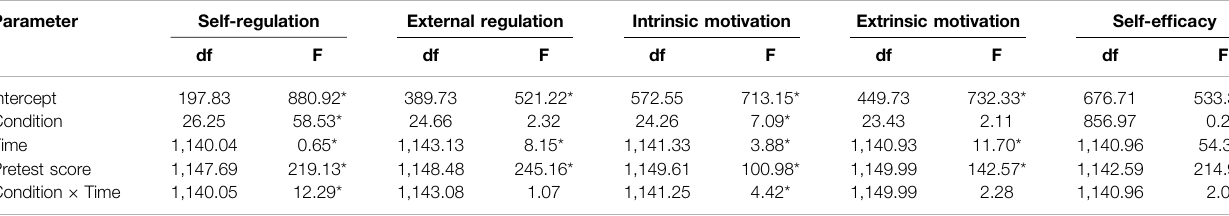
TABLE 6 | Fixed Effects for Predictors of Self-Regulation, External regulation, Intrinsic motivation, Extrinsic motivation, Self-ef fi cacy. Parameter